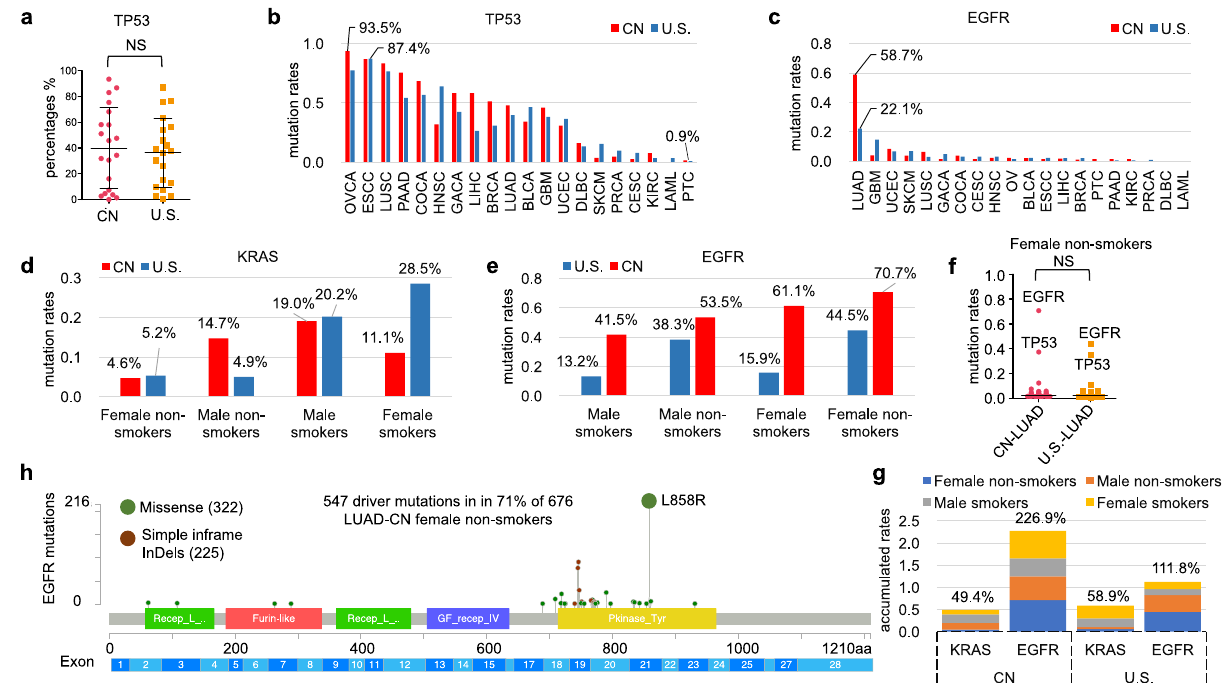
Fig.5|Thecomparisonof TP53 and EGFR mutationratesbetweenCNandU.S.a, b The mutation rates of TP53 , derived from the 20 most common cancer types, werecomparedbetweenCNandU.S.,respectively. p =0.6994(unpaired t test,two- tailed, t =0.3891, df =38; F test: F =1.379, DFn =19, Dfd =19, p =0.4899),CN _ Mean ±SE=0.4003±0.07017 ( n =20), U.S. _ Mean ± SE=0.3644±0.05975 ( n =20), 95% con fi denceinterval − 0.1508to0.2225. c Themutationratesof EGFR